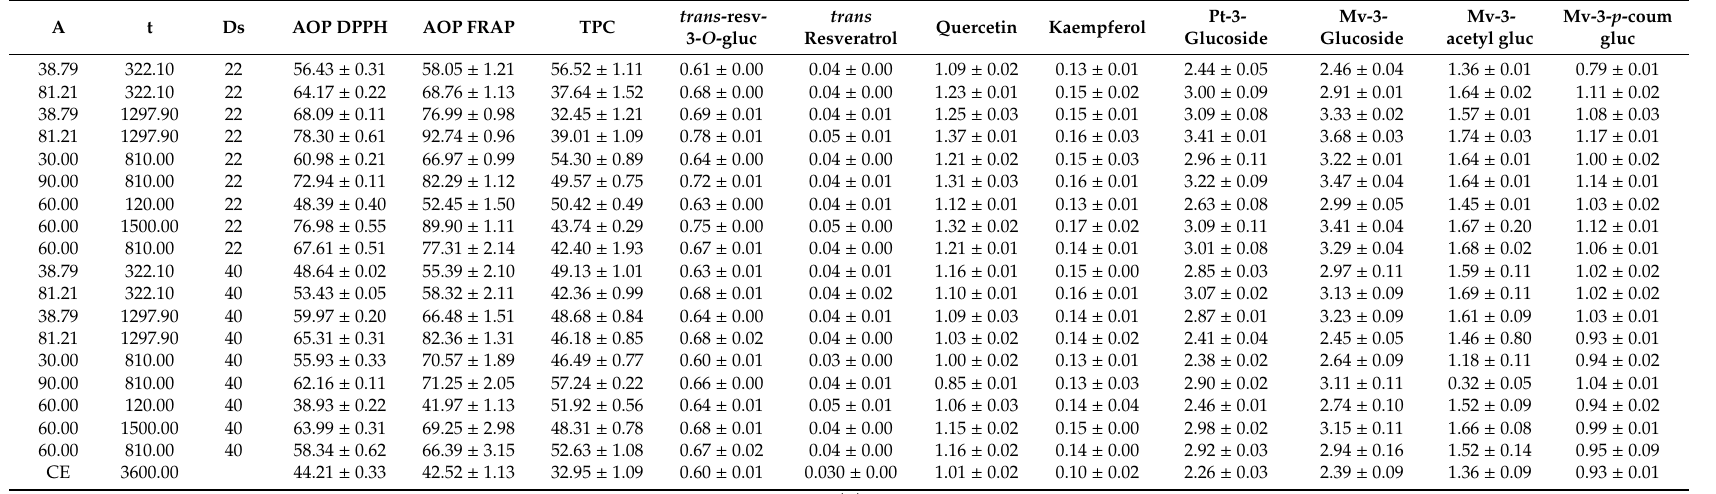
Table 1. ( a ) Concentration of investigated polyphenolic compounds and total antioxidants capacity (mg / g dry matter (d.m.)) in wine lees extracts for Merlot variety (ultrasound-assisted (UAE) and conventional aqueous (CE)); ( b ) Concentration of investigated polyphenolic compounds and total antioxidants capacity (mg / g dry matter (d.m.)) in wine lees extracts for Vranac variety (UAE and